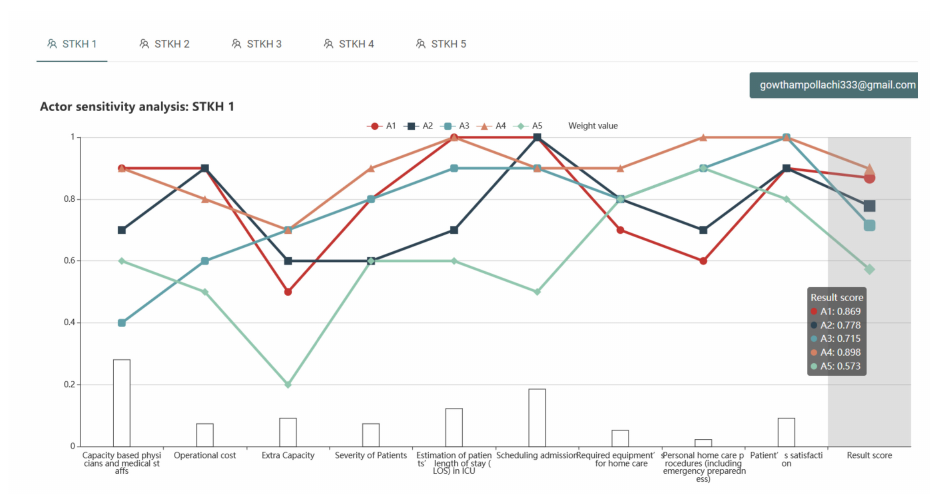
Figure A3. STKH 1 Sensitivity Analysis